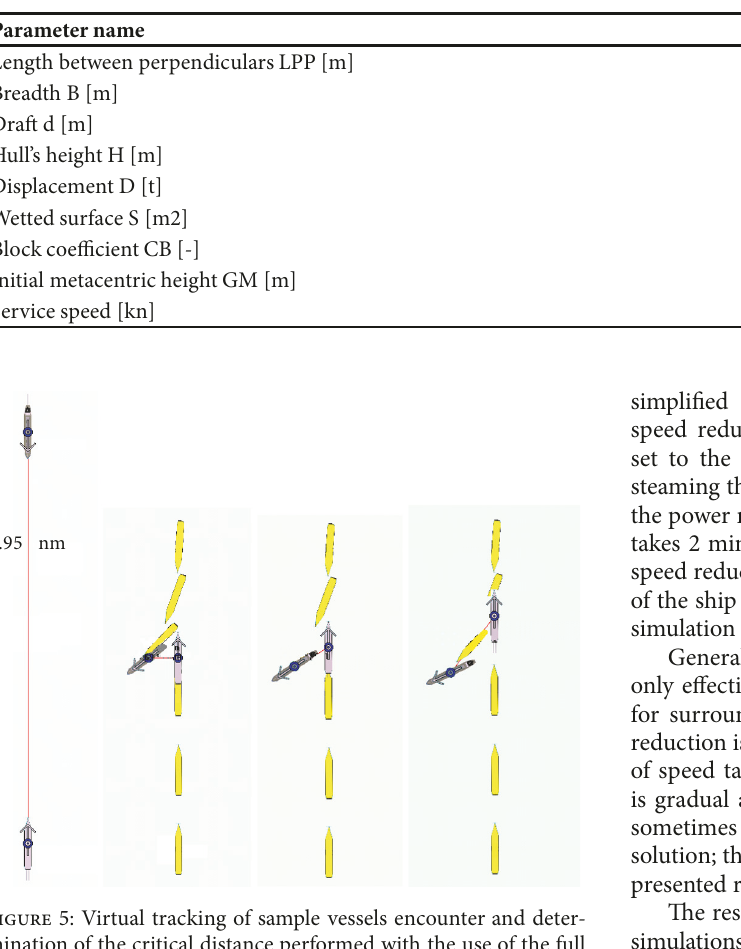
Table 1: Parameters of the ro-pax ship used throughout the simulations.